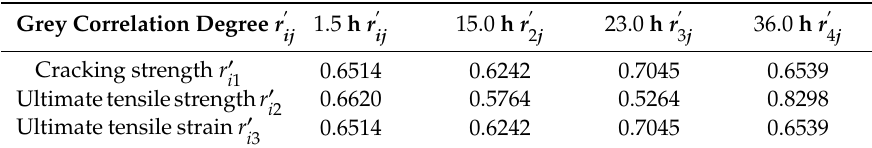
Table 7. Grey correlation degrees of the ages when vibrated on the tensile performance of PVA-ECC with a constant of duration of 5.0 h.